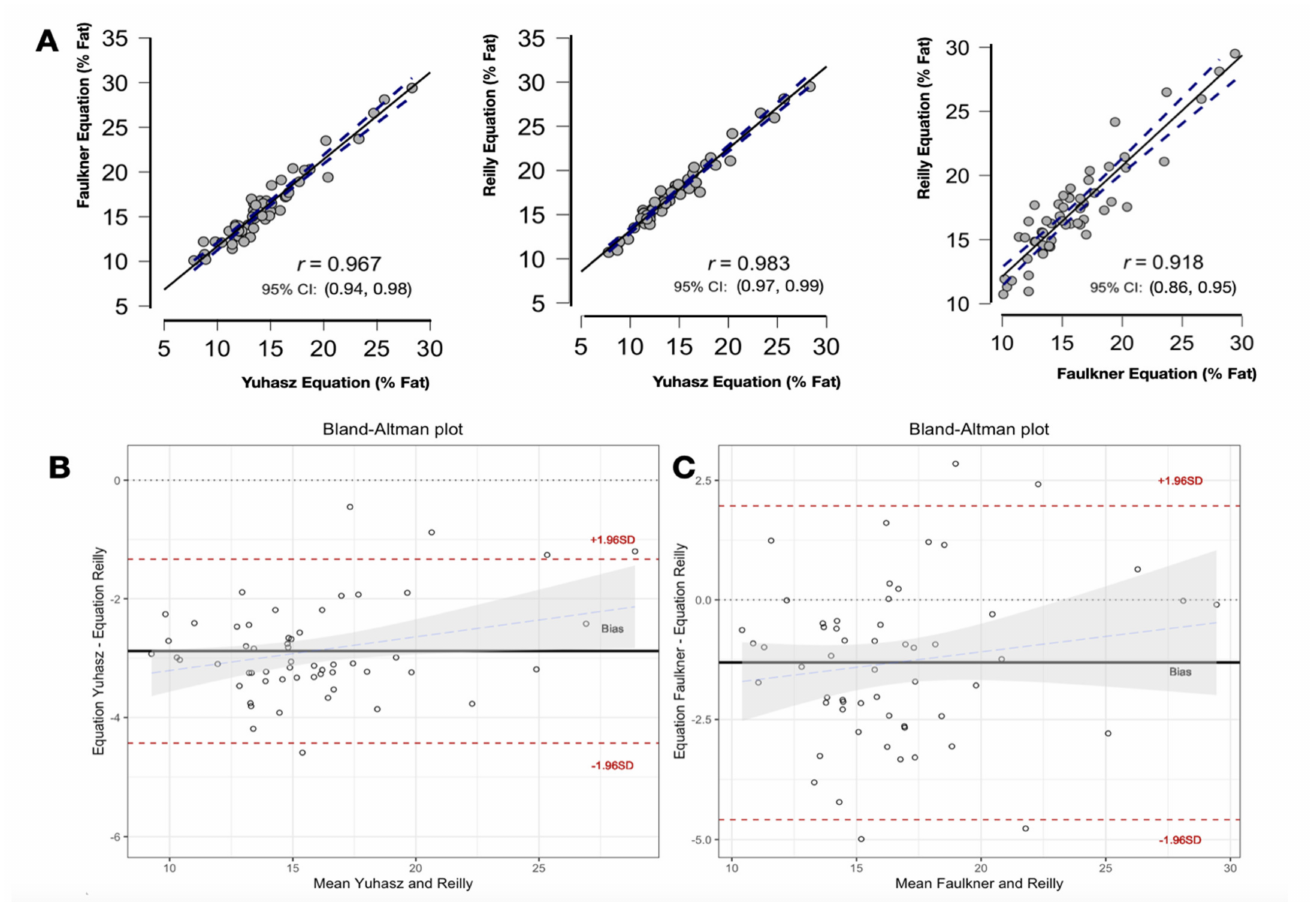
Figure 4. ( A ) Relationships between three fat percentage equations (i.e., Faulkner, Yuhasz, and Reilly). Bland − Altman plot comparing the mean differences and limits of agreement between ( B ) Yuhasz and Reilly equations and ( C ) Faulkner and Reilly